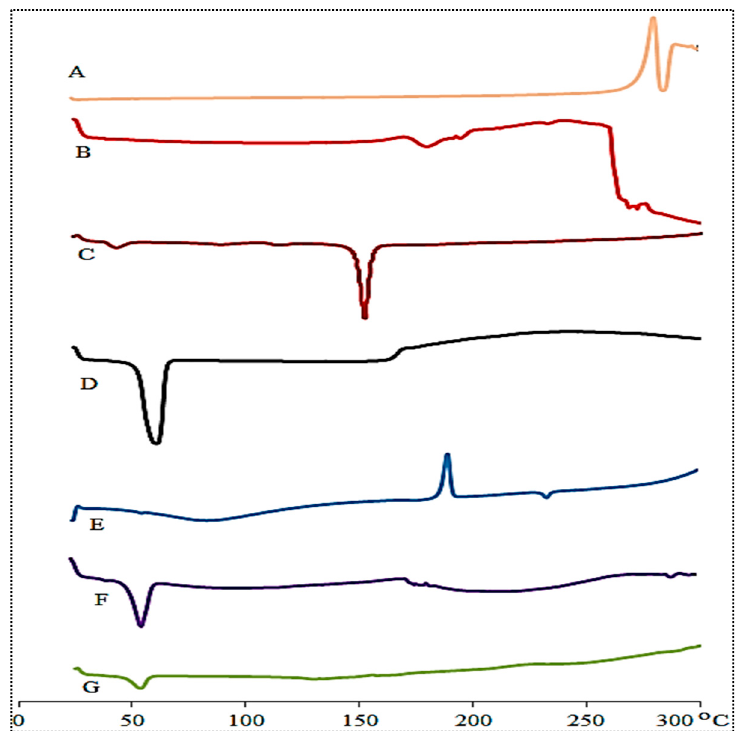
Figure 4. Thermal analysis of ( A ) diclofenac, ( B ) lipid, ( C ) cholesterol, ( D ) Pluronic F127, ( E ) sodium deoxycholate, ( F ), physical mixture, and ( G ) optimized diclofenac bilosomes (DC-BMs-opt).